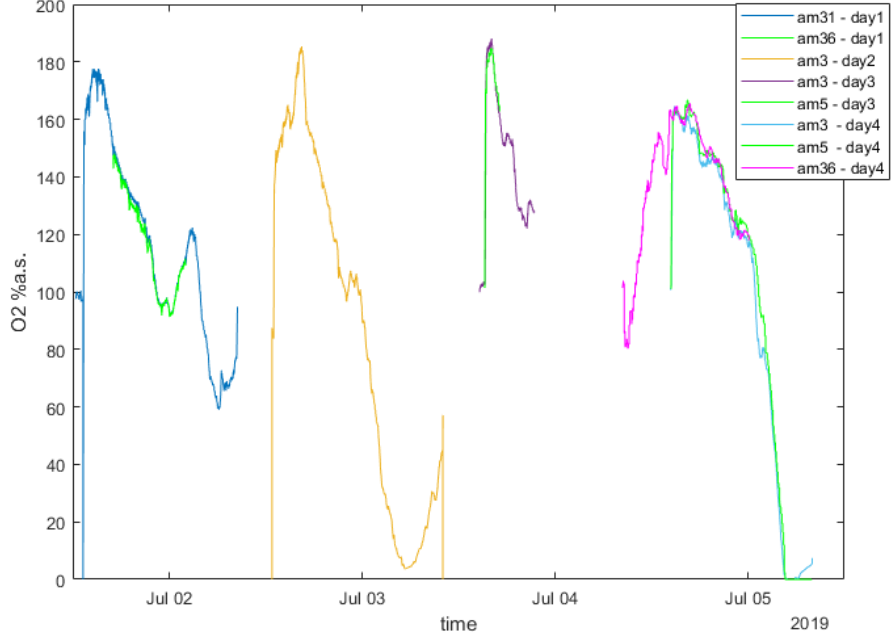
Figure 9. Example of oxygen data measured by aMussels.